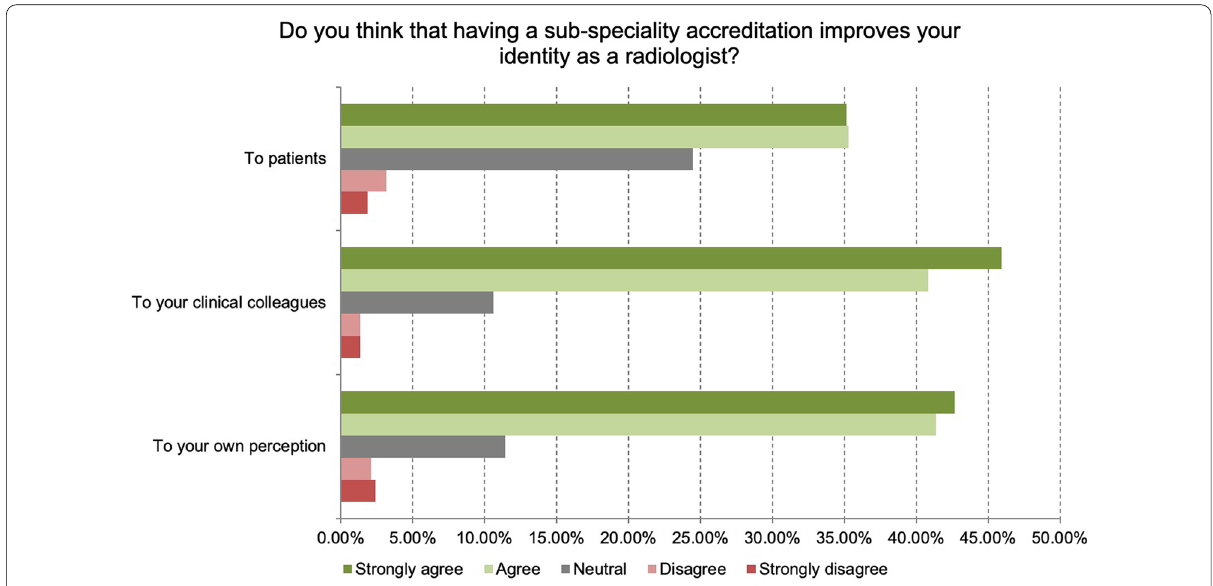
Fig. 5 Do you think that having a sub-speciality accreditation improves your identity as a radiologist? (responses n